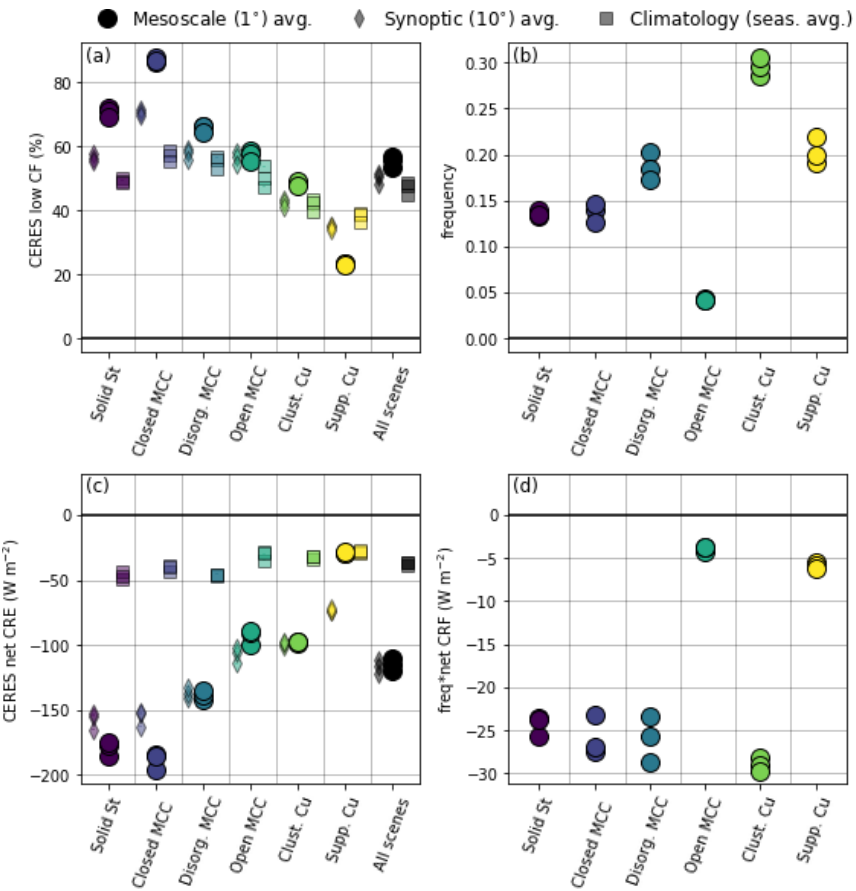
Figure 4. Cloud radiative properties by cloud type: (a) CERES cloud fraction, (b) cloud frequency of occurrence, (c) average CERES net CRE per cloud type, (d) frequency-weighted net CRE. Each set of three symbols is for the 3 years (2014–2016) used. For panels (a) and (c) , the mesoscale, synoptic, climatological averages are shown using circular, diamond, and square symbols, respectively (see Sect.